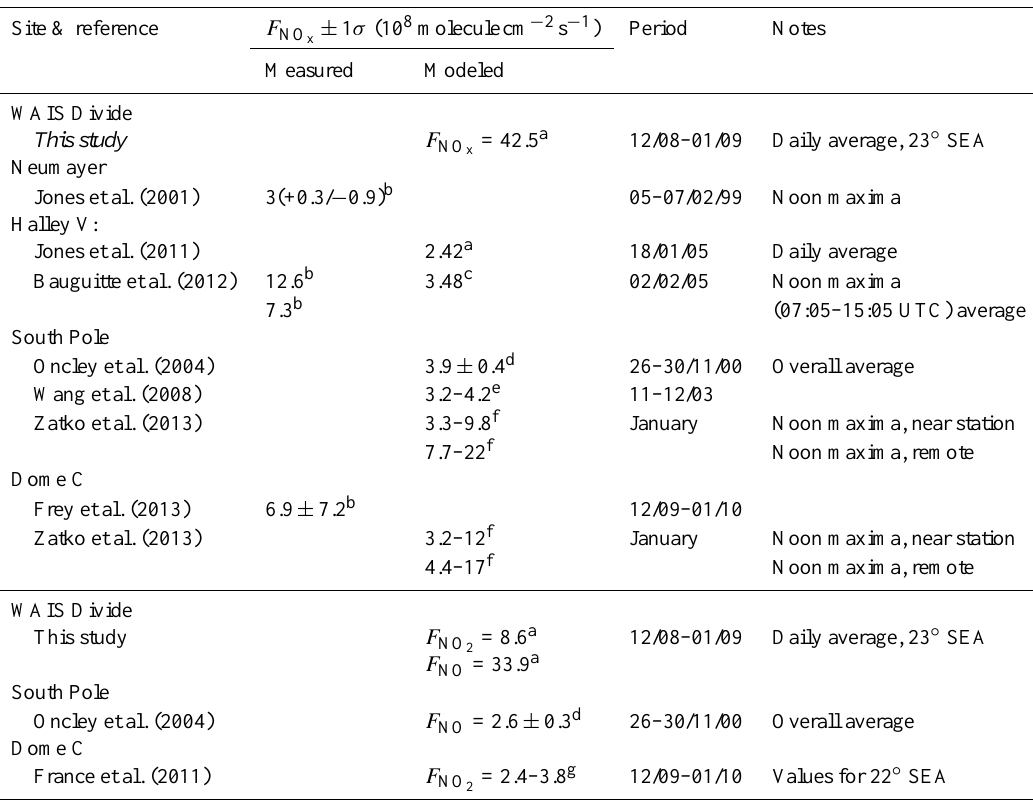
and NO − photolysis in snow at WAIS Divide compared to other Antarctic 3 2